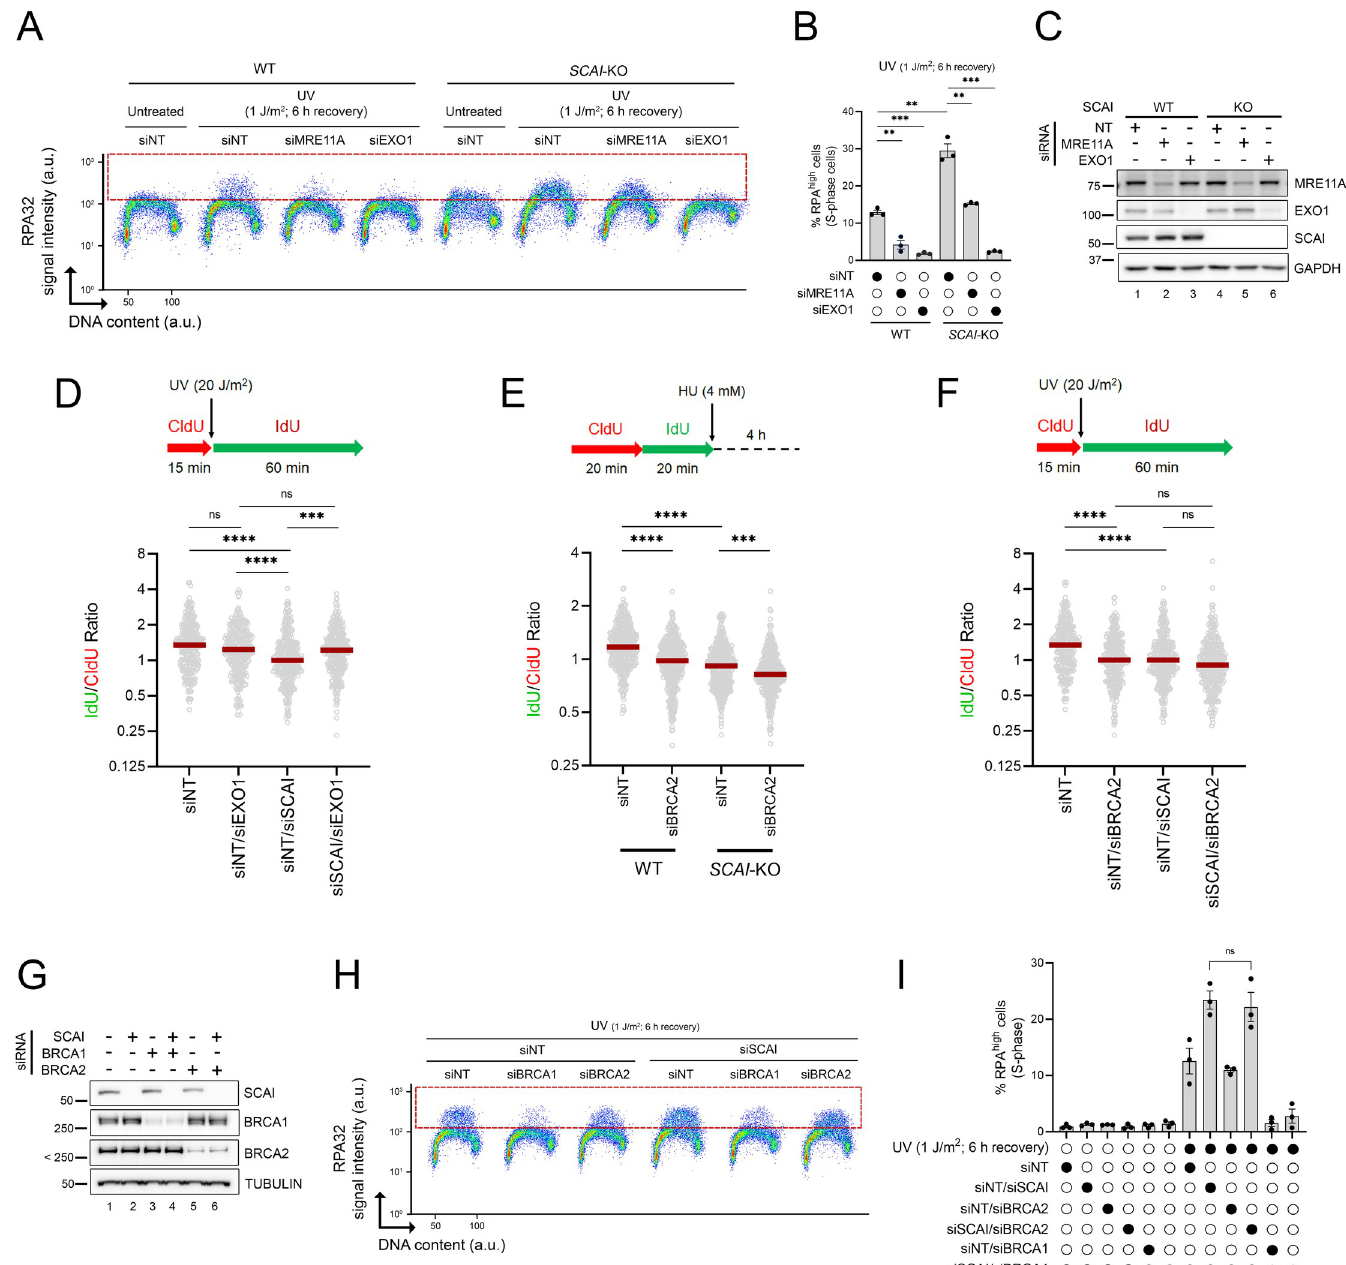
Fig 6. EXO1-dependent accumulation of ssDNA-RPA in cells lacking SCAI. (A) Depletion of EXO1, and to a lesser extent MRE11, rescues RPA-ssDNA accumulation post-UV in cells lacking SCAI. Cells were treated with 1 J/m 2 UV or mock-treated and allowed to recover for 6 h. The dashed red box delineates DNA- bound RPA high cells. ( B) Quantification from (A). Values represent the mean ± SEM from 3 independent experiments. ( C) Immunoblot analysis showing EXO1 or MRE11 depletions from whole-cell extracts from U-2 OS (WT) or SCAI-KO (#1) cells transfected with siRNAs. ( D) Top: schematic of the DNA fiber assay used to assess RF progression post-UV. Cells were incubated with CldU (red) for 15 min, irradiated with UVC (20 J/m 2 ), and then incubated with IdU (green) for 60 min. Bottom: dot plot of IdU/CldU ratio and median (red line) from U-2 OS transfected with siNT or siRNA against EXO1 (data combined from n = 2 with similar results). ( E) Top: schematic of the DNA fiber assay to monitor RF protection defects (nascent DNA degradation) after HU. Cells were incubated successively with CldU (red) and IdU (green) for 20 min each and then exposed to 4 mM HU for 4 h. Bottom: dot plot of IdU/CldU ratio and median (red line) from U-2 OS (WT) and SCAI - KO (#1) cells transfected with siRNAs against BRCA2 (data combined from n = 2 with similar results). ( F) Similar experiment as in (D) but from U-2 OS transfected with siNT or siRNA against BRCA2 (data combined from n = 2 with similar results). ( G-I) Lack of BRCA1/2 does not cause RPA-ssDNA accumulation under our experimental conditions. (G) Validation of BRCA1 and BRCA2 KDs by immunoblot. ( H) Experiments were performed as in (A) but with cells transfected with siRNAs against BRCA1 or BRCA2 +/ − siSCAI. ( I ) Quantification from (H). Values are the mean ± SEM from 3 independent experiments. Statistics used: unpaired t test corrected for